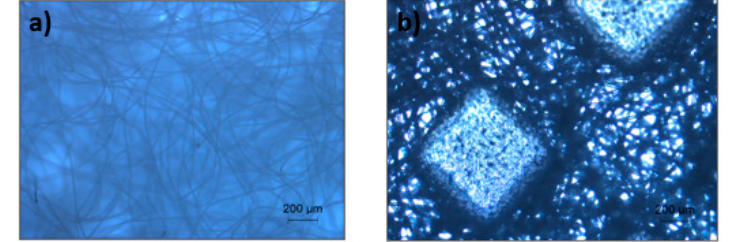
Figure 9. Morphology of PES nonwoven for ( a ) inner and ( b ) outer layer under an optical microscope.